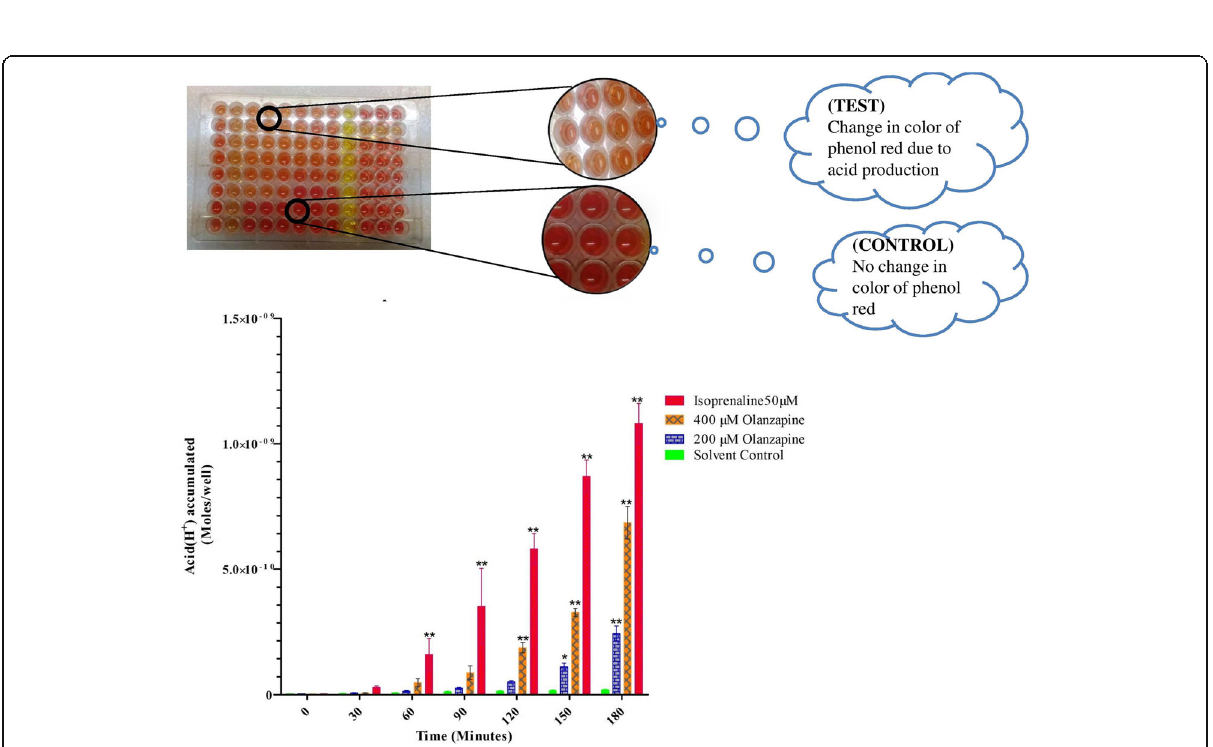
Fig. 5 Effect of olanzapine (400 μ M and 200 μ M) on metabolic rate. Data are shown in 30 min interval. All the data are expressed in mean ± SEM. Number of larvae in each group ( n ) = 8. * p < 0.05, ** p < 0.001 significantly different versus solvent